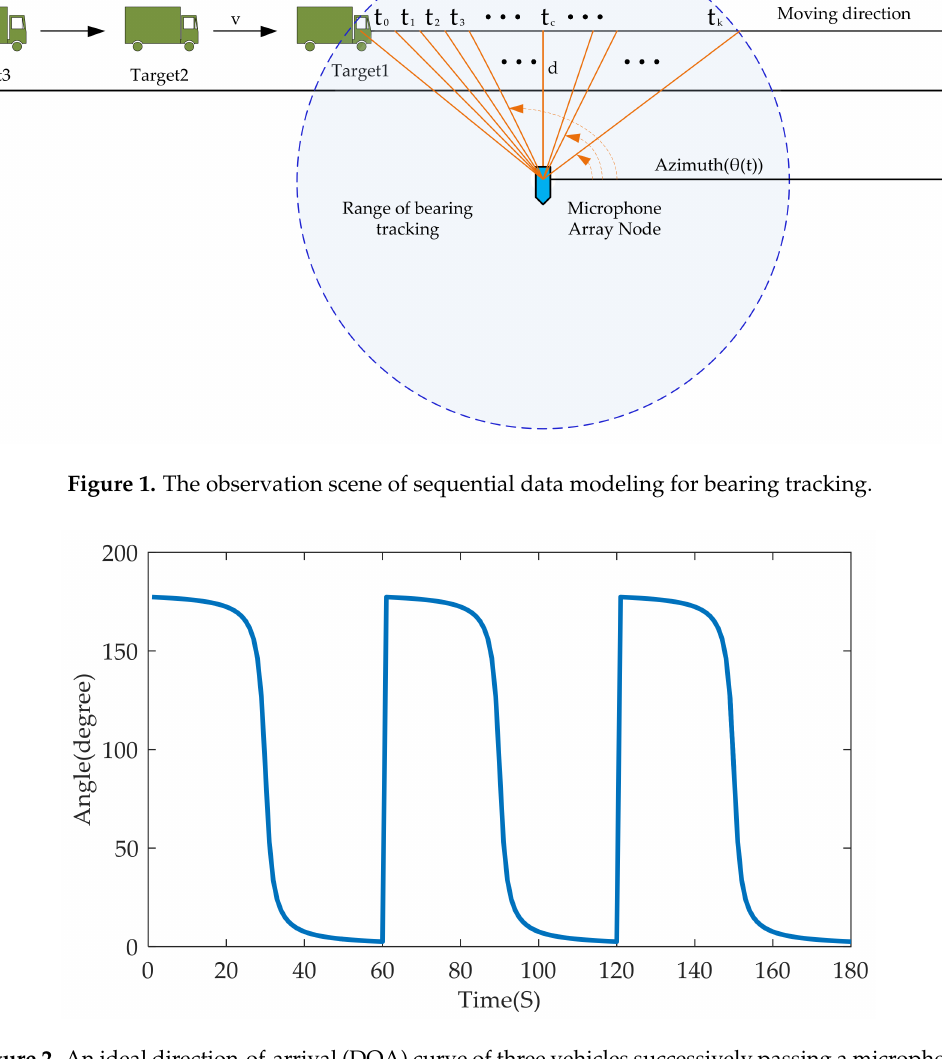
Figure 2. An ideal direction-of-arrival (DOA) curve of three vehicles successively passing a microphone array